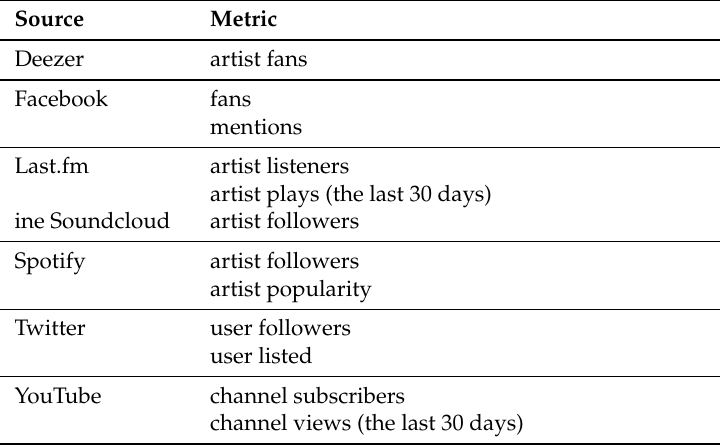
Table 2. Web-based sources and metrics for artist